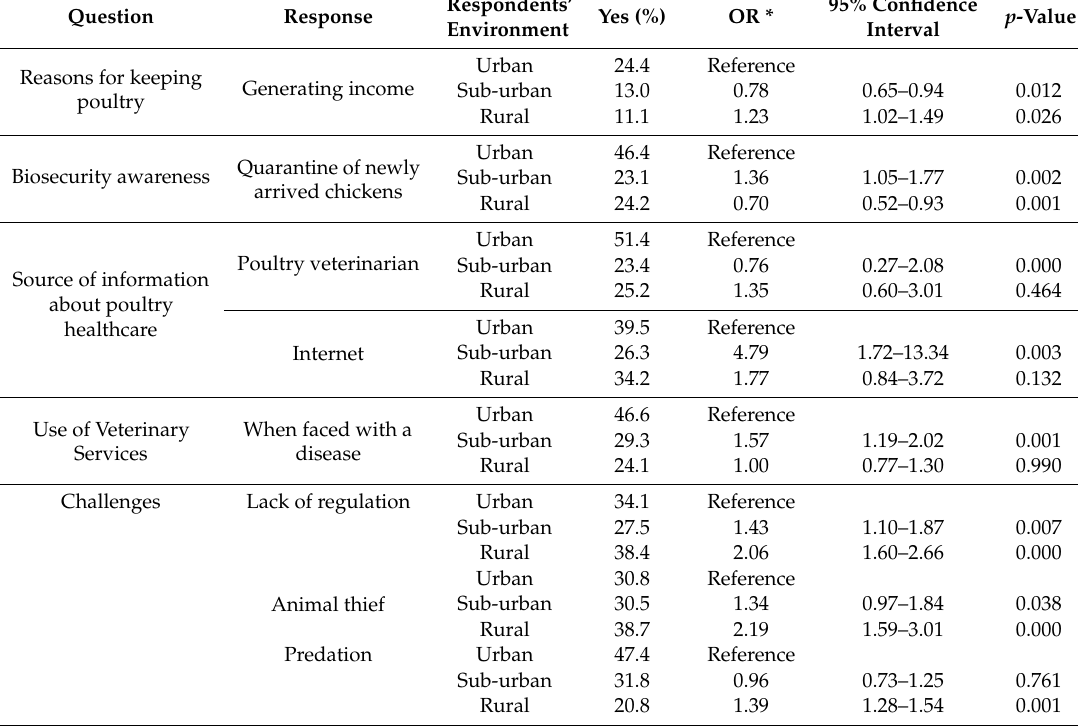
Table 1. The association between respondents’ living environment in terms of backyard poultry practices and